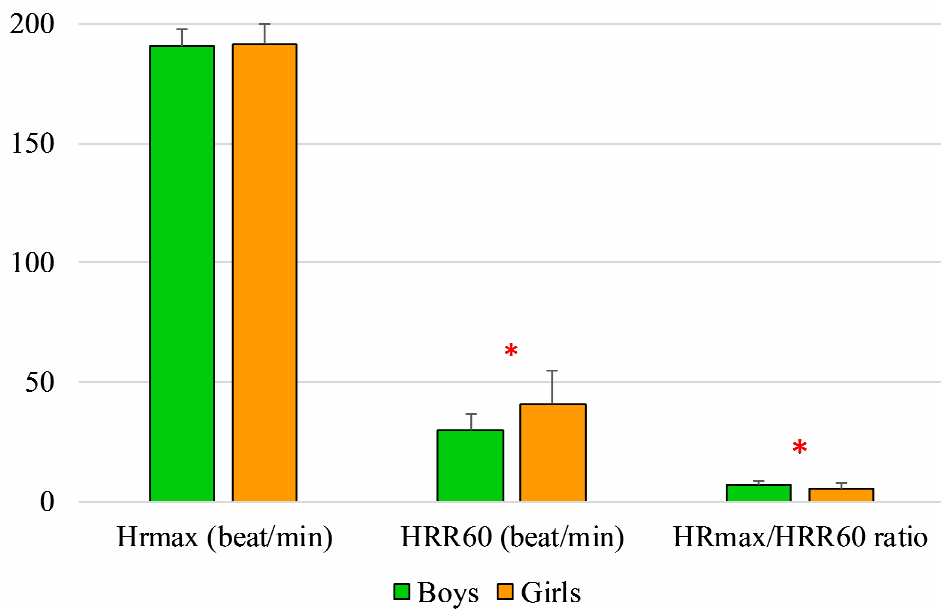
Figure 2. Boys’ and girls’ heart rate changes (* p < 0.05). HRmax: maximal heart rate during the maximal exercise; HRR60: difference between the heart rate at the end of the 200 m freestyle swimming and 60 s later; HRmax/HRR60: ratio of maximal heart rate during the 200 m maximal freestyle swimming and the difference between the heart rate at the end of the 200 m freestyle swimming and 60 s later.